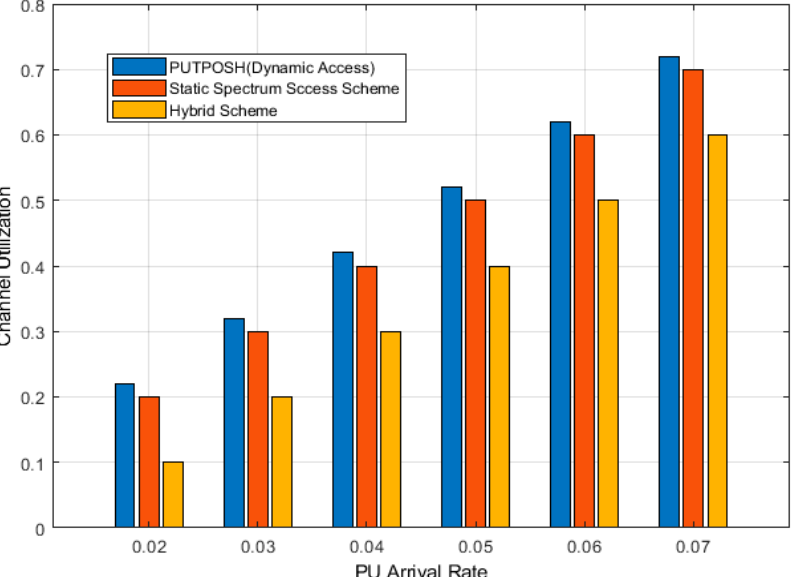
Figure 9. Comparison of PUTPOSH with stationary (reactive and proactive) spectrum access, and hybrid schemes w.r.t. the channel utilization.